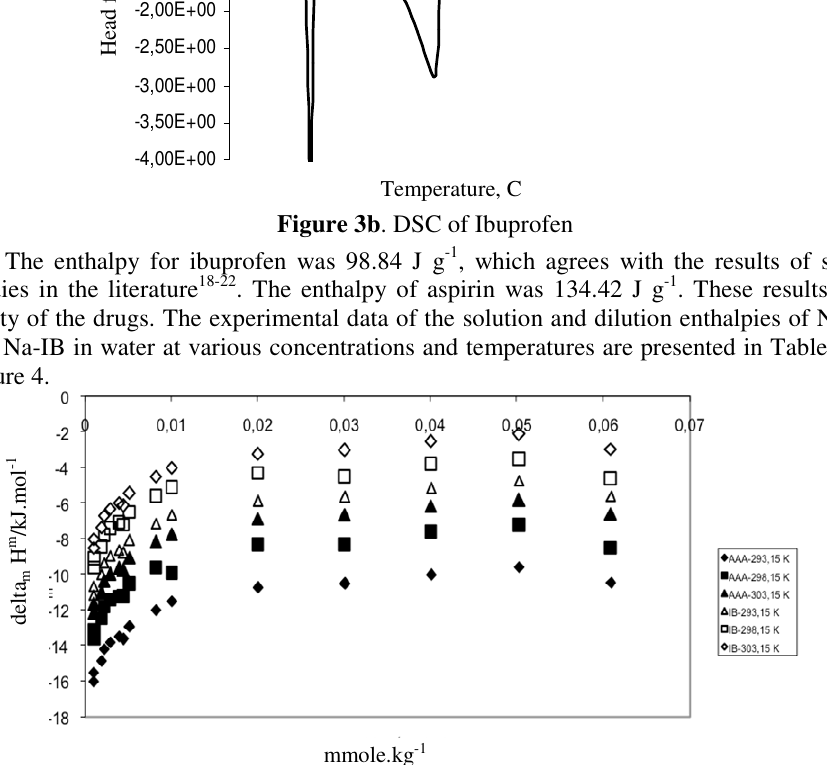
Figure 4. Concentrations dependencies of Na-AA and Na-IB solution enthalpies in water at different